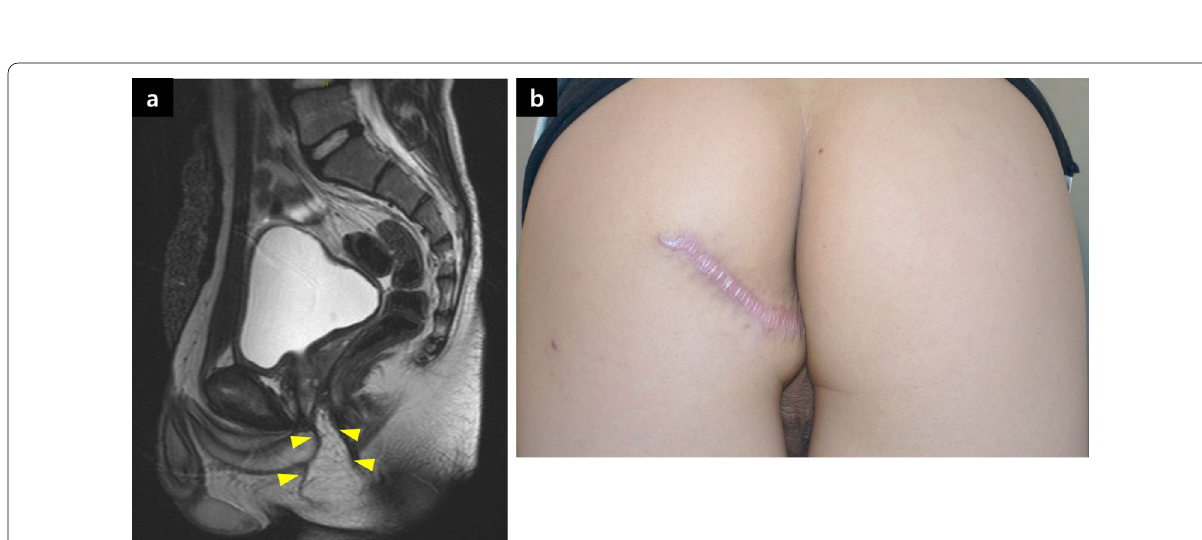
Fig. 6 Postoperative images. a Pelvic magnetic resonance imaging 5 months postoperatively revealed the interposed flap between the urethra and rectum without atrophy and deviation (yellow arrowhead). b Scars on the